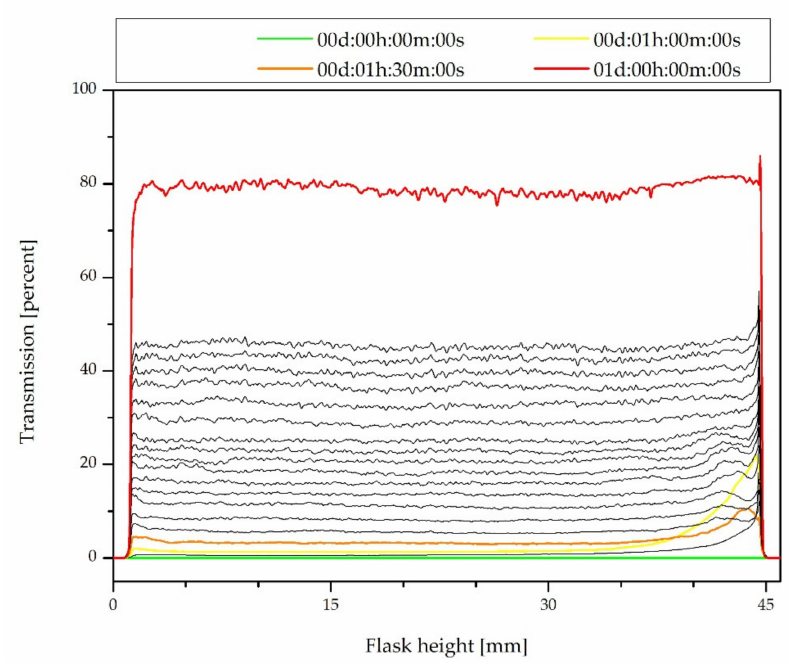
Figure 2. Transmission profiles of the coating composition just after the